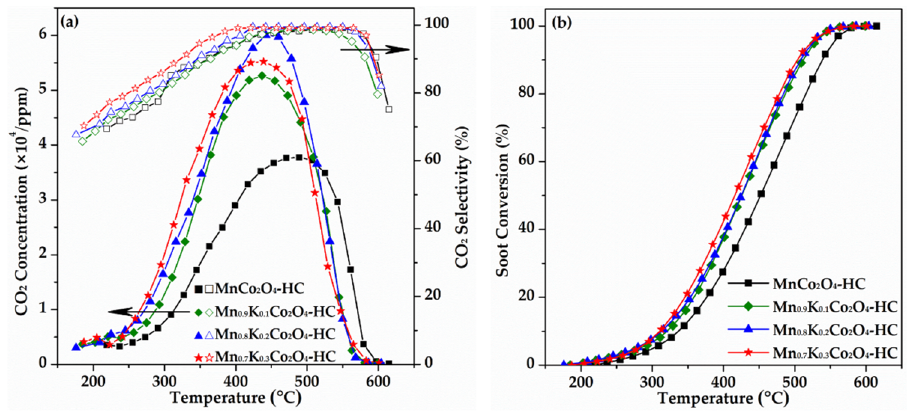
Figure 1. The curves of CO 2 concentration and selectivity to CO 2 ( a ) and soot conversion curves ( b ) over as-prepared monolith catalysts. Table 1. Catalytic performance, stability and tolerance of sulfur dioxide and water for soot combustion of as-prepared monolith catalysts.